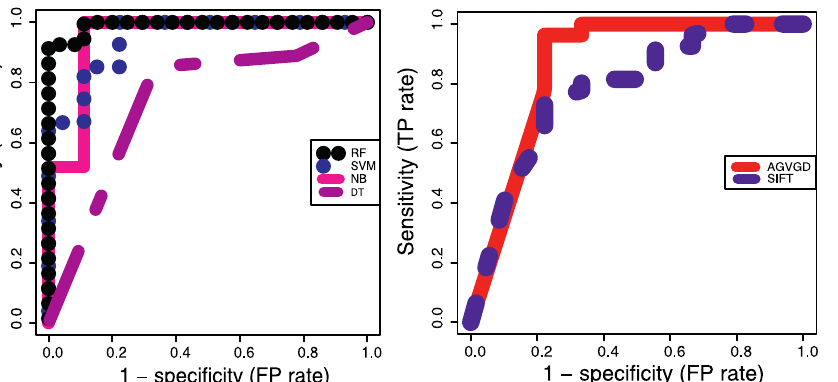
Figure 2. Sensitivity versus 1-Specificity of Classifiers That Use a Numerical Score to Predict the Functional Impact of 34 BRCA1 BRCT UCVs Comparison of four supervised machine learning methods, trained on 618 biochemically characterized missense variants in the human transcription factor TP53 and two sequence analysis methods that consider evolutionary conservation and physiochemical properties of amino acids (SIFT and Align- GVGD Tnig based on alignment of eight placental mammals, marsupial, chicken, frog, and pufferfish). Align-GVGD Spur, using an alignment that includes these species plus sea urchin, performs slightly worse than Align-GVGD Tnig in terms of ROC analysis and is not shown. Plot created with ROCR [86]. DT, decision tree; NB, Naı ¨ ve Bayes; RF, random forest; SVM, support vector machine.